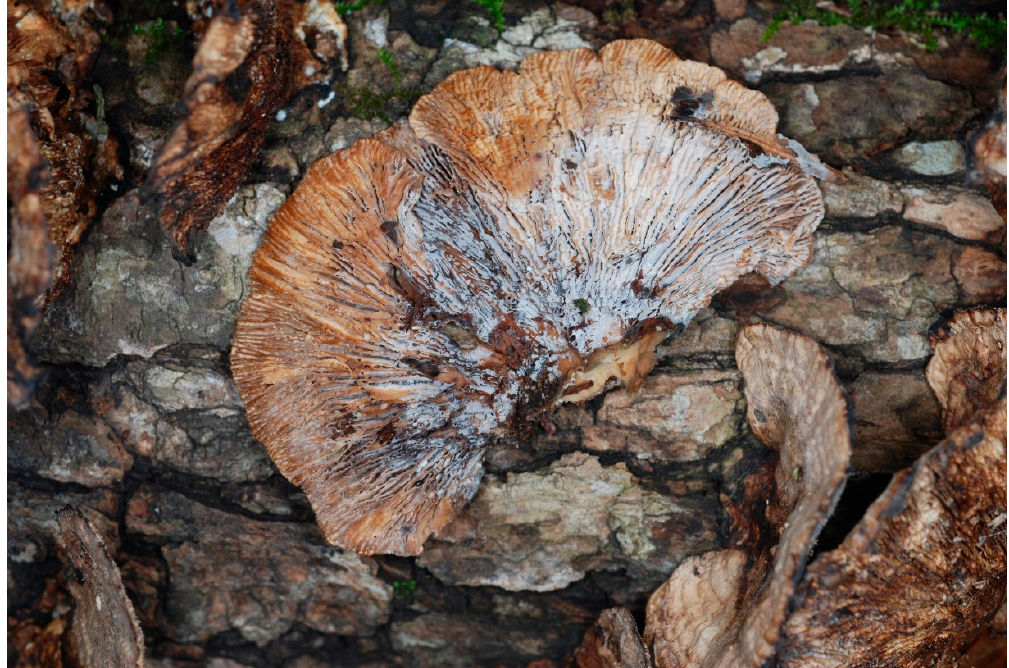
Figure 1. White superficial mycelium and conidia of Sphaerostilbella toxica parasitizing the lamellae of Gloeophyllum striatum . The type collection DPL-12808 (=NRRL 66954), from near Bleakwood (TX, USA), Texas. Photo by David P. Lewis.